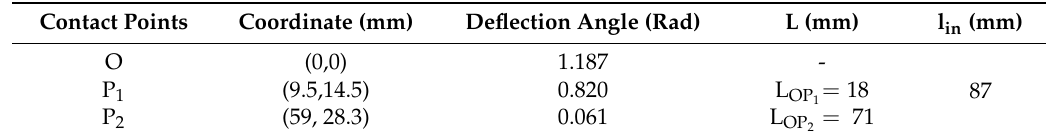
Table 4. Contact information about position I.